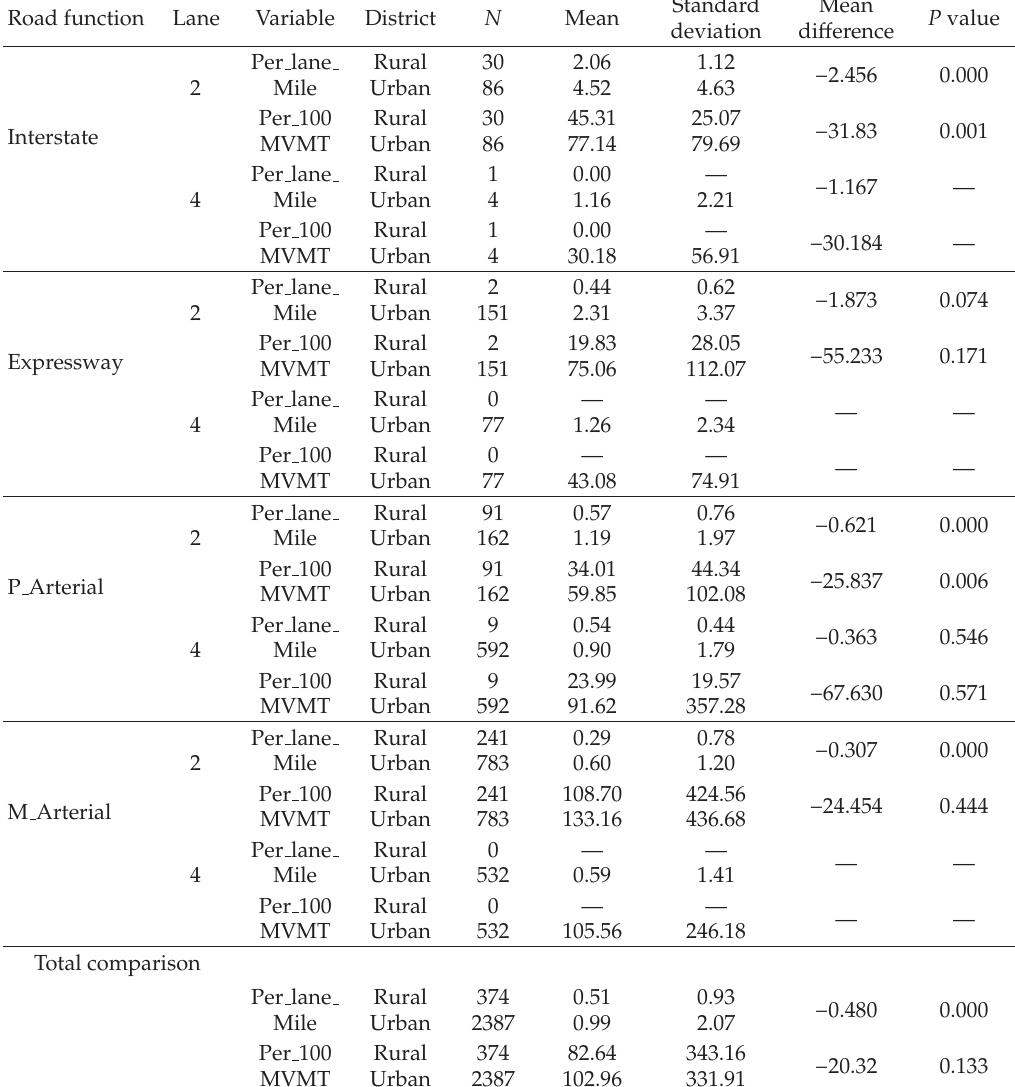
Table 3: t -test statistics for rural and urban segment